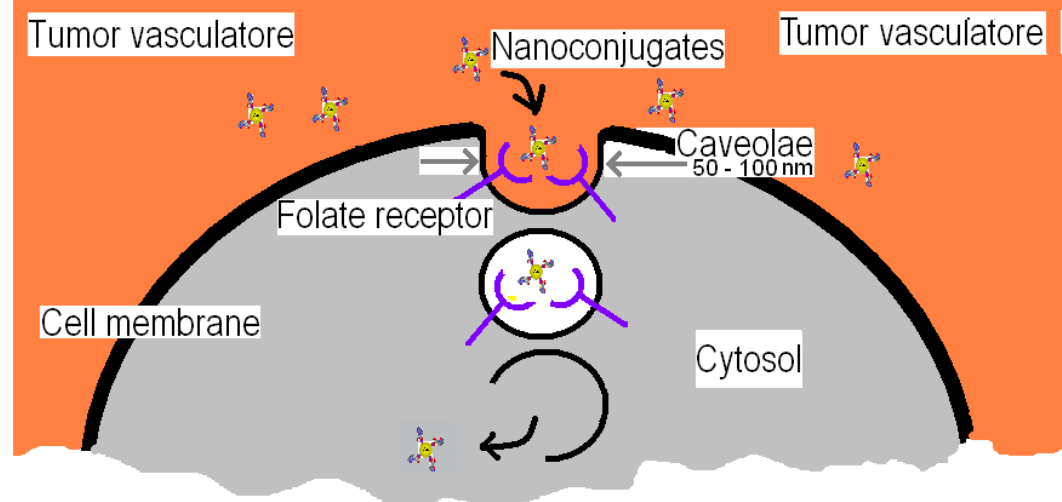
Figure 3. Various stages of (AuNP-Linker-Folate) nanoconjugate transfer in the cell through the folate-receptor on the cancer cell’s